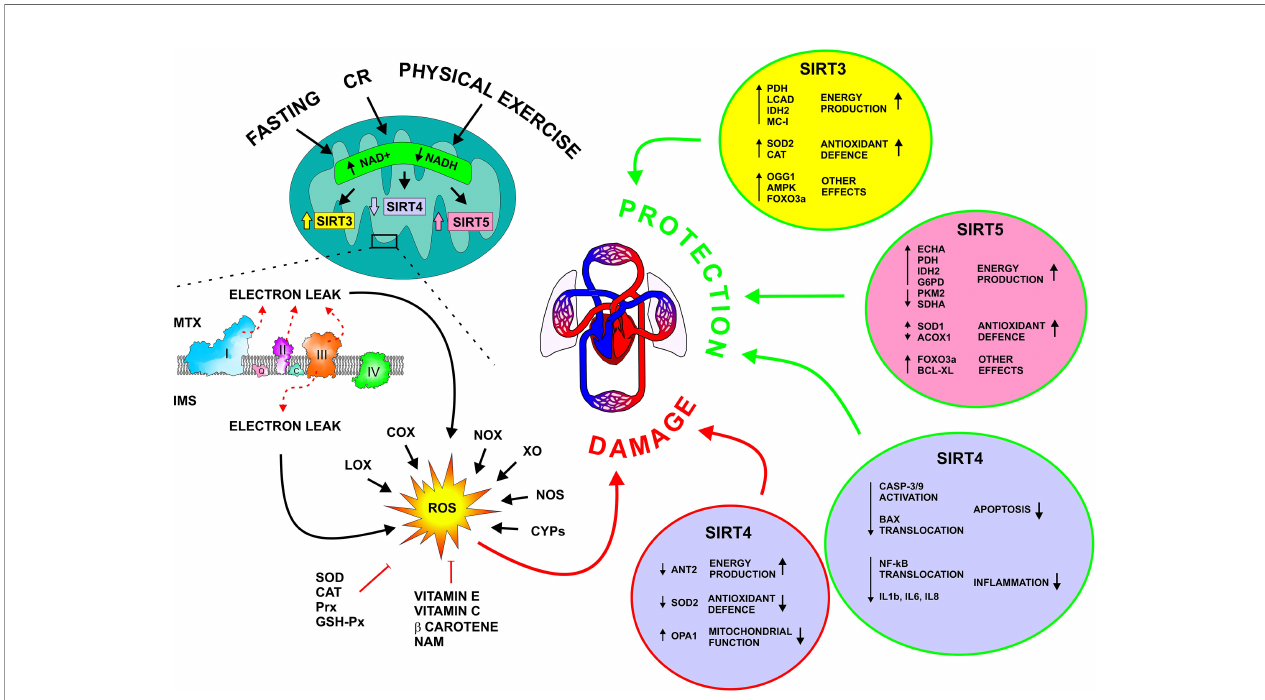
FIGURE 1 | Molecular mechanisms underlying ROS production and the activity of mitochondrial sirtuins on CVD. SIRT3, 4, and 5 control cellular metabolism, and mitochondrial and ROS homeostasis. Dietary interventions, in the forms of fasting and calorie restriction, as well as physical exercise, stimulate SIRT3 and 5 and repress SIRT4. SIRT3 and 5 activate energy production and antioxidant pathways, resulting in the protection of the cardiovascular system, particularly during metabolic and oxidative stress. Differently, SIRT4 seems to have both a detrimental and a bene fi cial effect on the cardiovascular system. ACOX1, Acyl-CoA Oxidase 1; AMPK, AMP-Activated Protein Kinase; ANT2, Adenine Nucleotide Translocator 2; Bcl-XL, B-cell lymphoma extra-large; CASP-3/9; Caspase 3 and 9; CR, Calorie Restriction; COX, Cytochrome C Oxidase; CYPs, Cytochrome P450; ECHA, Enoyl-Coenzyme A Hydratase; FOXO2A, Forkhead Box O3A; G6PD, Glucose-6- Phosphate Dehydrogenase; GSH-Px, Glutathione peroxidase; IDH2, Isocitrate Dehydrogenase 2; IL1b, Interleukin 1 beta; IL6, Interleukin 6; IL8, Interleukin 8; IMS, intermembrane space; LCAD, Long-Chain Acyl-CoA Dehydrogenase; LOX, Lipoxygenase; MC-I, Mitochondrial Complex I; mTOR, Mammalian Target Of Rapamycin; MTX, Mitochondrial Matrix; NAM, Nicotinamide; NF-kB, Nuclear factor-kappa b; NOS, Nitric Oxide Synthases; NOX, NADPH Oxidase; OGG1, 8-oxoguanine-DNA glycosylase; OPA1, Optic Atrophy 1; Prx, Peroxiredoxin; PDH, Pyruvate Dehydrogenase; PKM2, Pyruvate Kinase M1/2; ROS, Reactive oxygen species; SDHA, Succinate Dehydrogenase Complex, subunit A; SOD, Superoxide Dismutase; XO, Xanthine